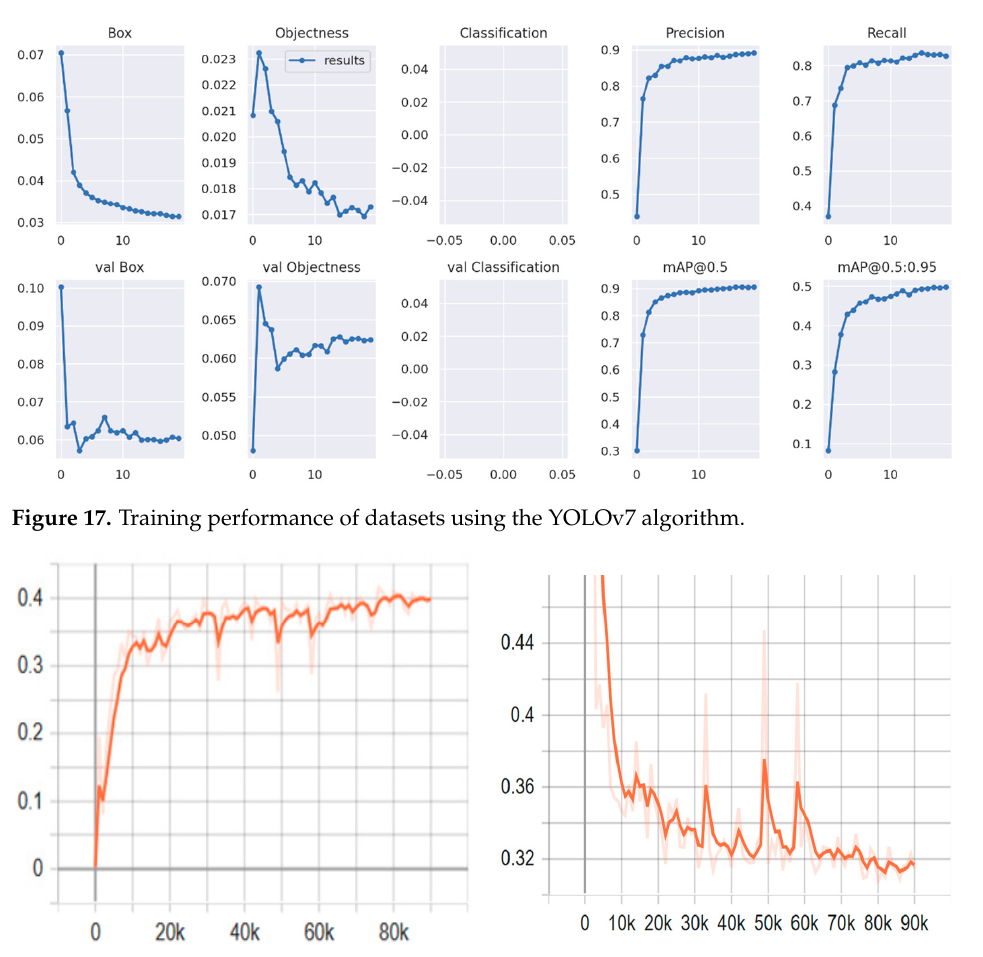
Figure 16. Training performance of datasets using the YOLOv5 algorithm.